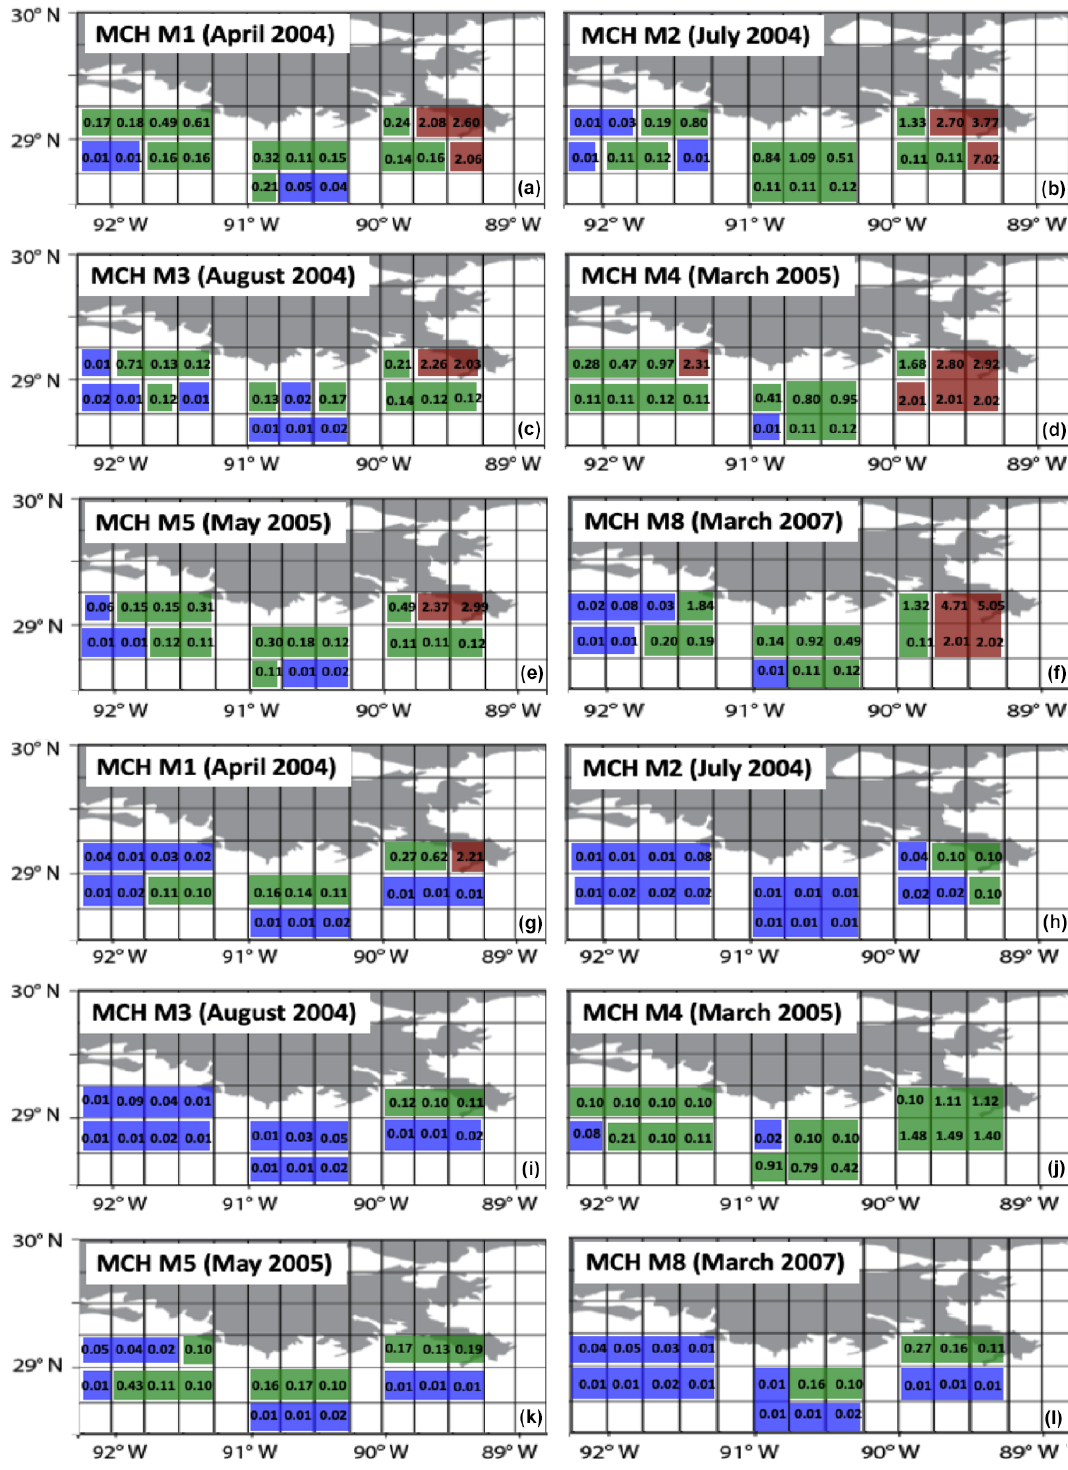
Figure 6. Areal distributions of the three zones using data from above the pycnocline (a–f) , based on N mass balance model results. Colors and numbers represent boxes found in each of the three zones in terms of potential productivity (unit: gCm − 2 d − 1 ). As previously, these distributions use data from below the pycnocline (g–l)